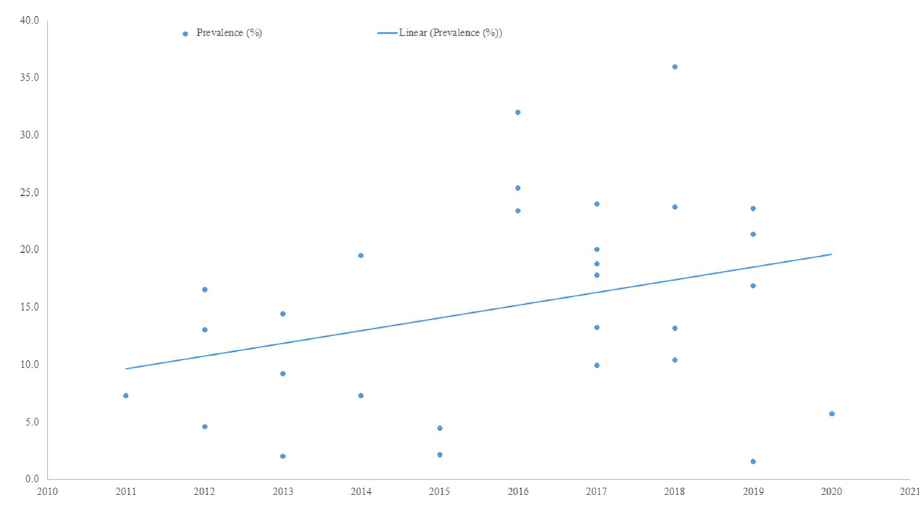
Fig 9. The time trend of LTFU among HIV positive adolescents in sub-Saharan Africa from 2005 to 2020.